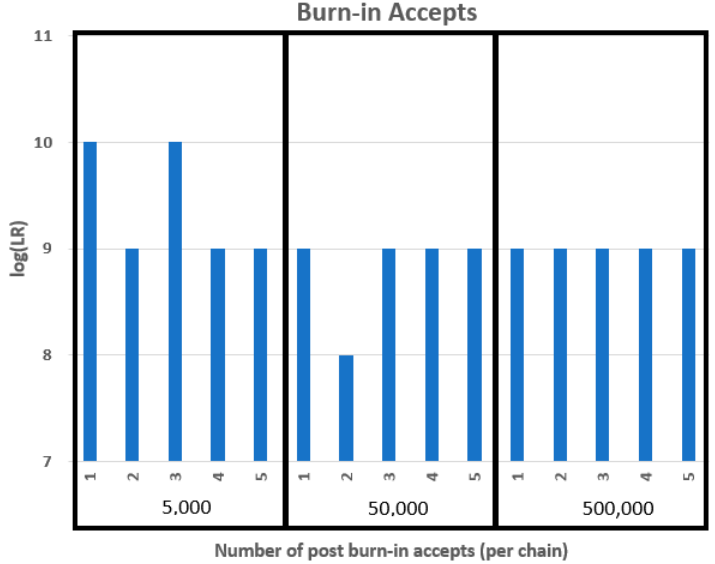
Figure 6. DSCS post burn-in accepts.